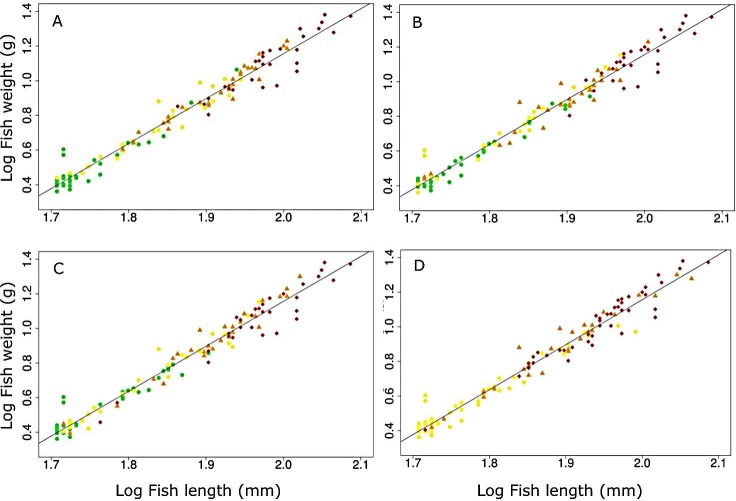
Relationships between fish size and weight in relation to abundances of the parasites Apatemon sp.(A), Stegodexamene anguillae (B), Telogaster opisthorchis (C), and Eustrongylides sp. (D). Abundance is grouped into quartiles (1st Quartile: green triangles; 2nd Quartile: yellow dots; 3rd Quartile: brown squares, and 4th Quartile: red diamonds). Zero abundance values comprised the first two quartiles of data for Eustrongylides sp. Plots are only shown for parasites whose abundances are highly correlated with fish size (r > 0.70) (see main text).